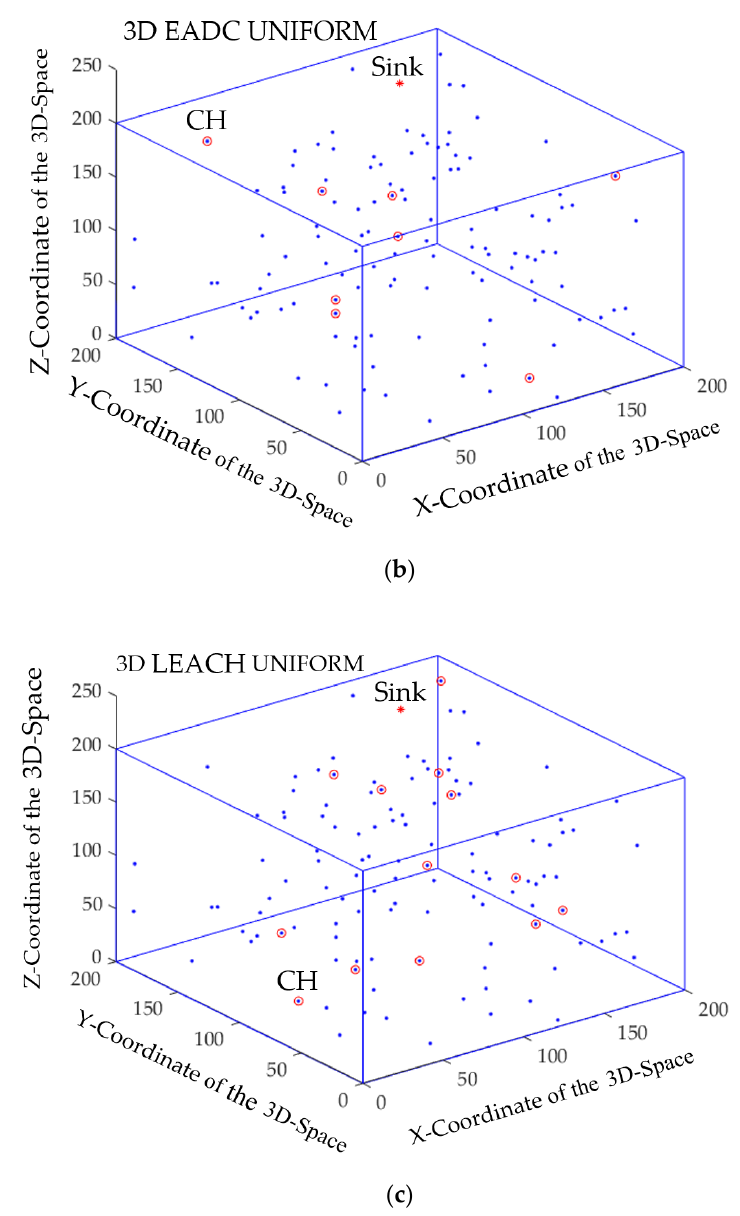
Figure 2. Elected RC/cluster head (CH) nodes in the three-dimensional wireless sensor network (3D WSN) field of: ( a ) eccentricity based data routing (EDR) ;( b ) 3D energy-aware distributed clustering (3D EADC); ( c ) 3D low energy adaptive clustering hierarchy (3D LEACH).